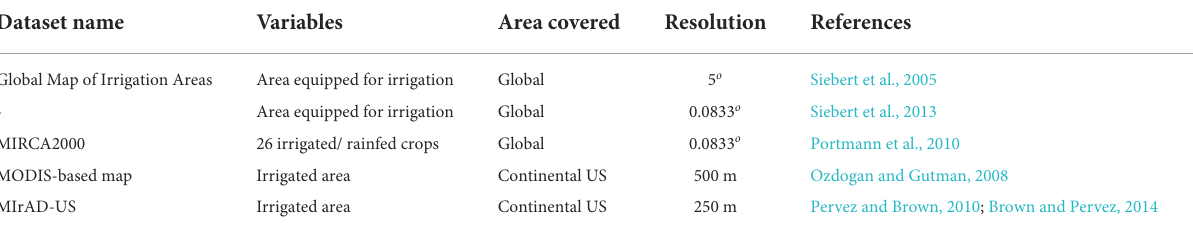
TABLE 1 Table that summarize the available geographical dataset about area irrigated or equipped for